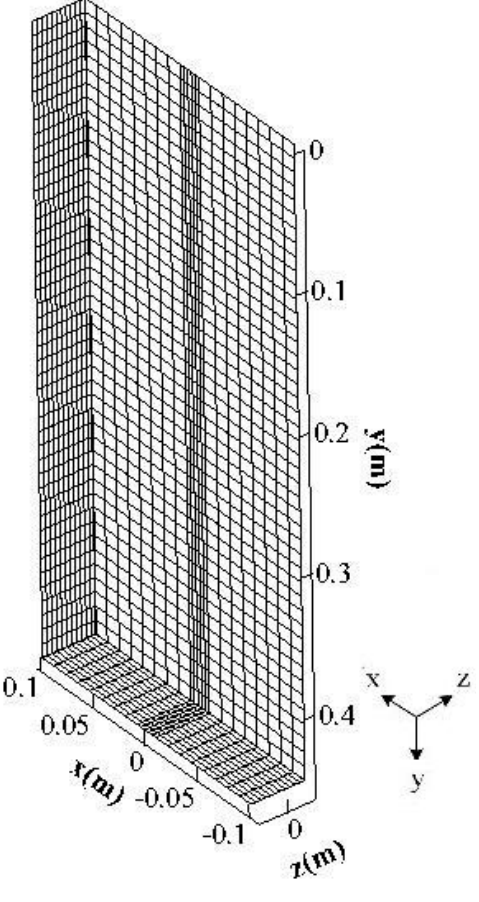
Figure 2. Mesh of case No. 1.